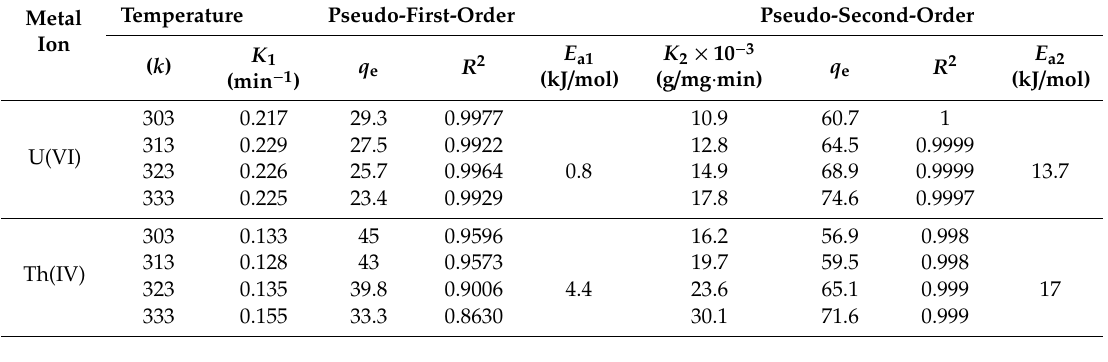
Figure 12. Plot of t / q t versus time for ( a ) U(VI) and ( b ) Th(IV) sorption onto HQ-bentonite. Conditions: Figure 13. Variation of log k 1 and log k 2 with 1/ T for sorption of U(VI) onto HQ-bentonite (Arrhenius plot).